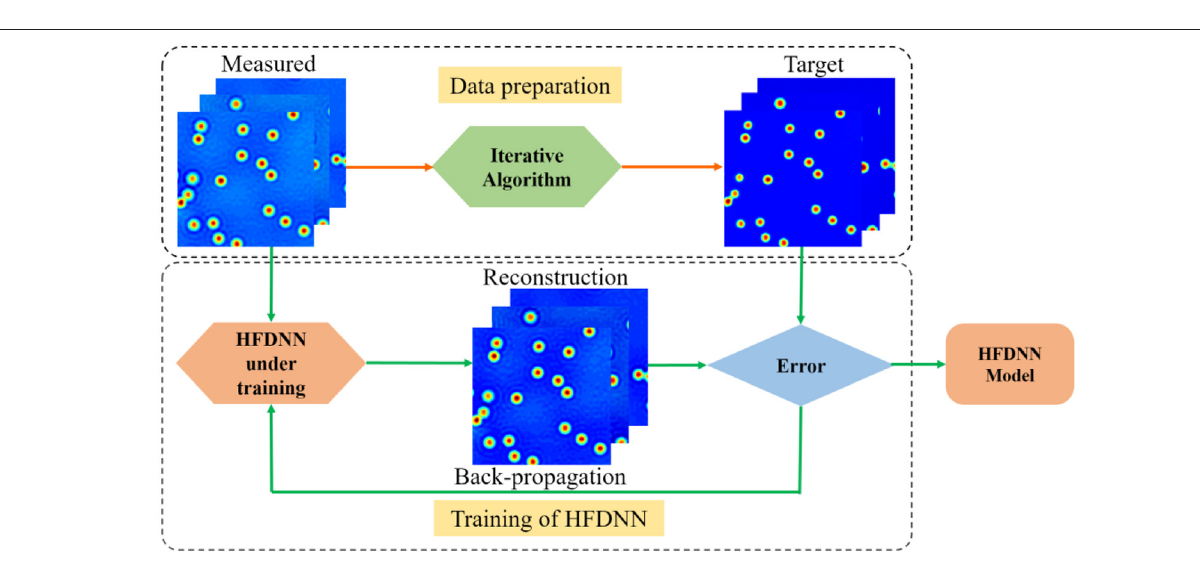
FIGURE 3 | A schematic of the process of the HFDNN training. In the process of data preparation, the measured images are acquired by our wDPM system, which are used as the input data; the measured images are reversed into the halo-free images by the iterative algorithm, which are used as the target data. In the process of the HFDNN training, when the error remains a constant or reaches a value, the training is terminated and the HFDNN model is